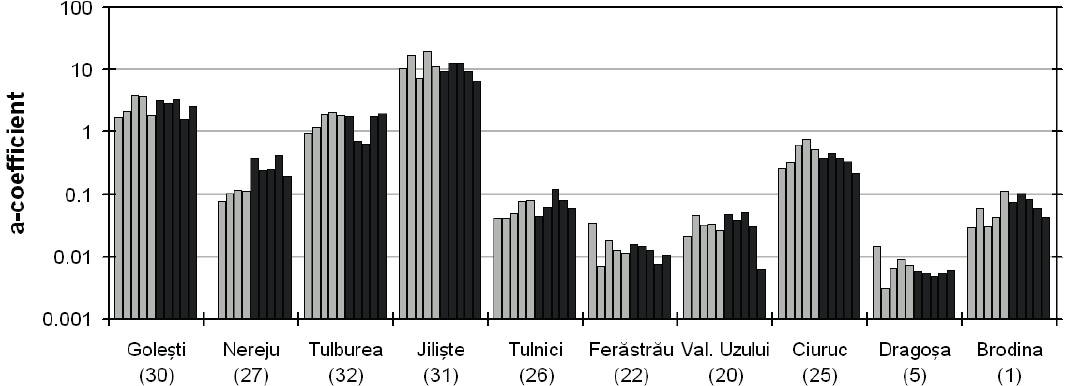
Fig. 3 a coefficients of the sediment rating curves (equation (1)) for the five consecutive hydrological years before (light grey) and after (dark grey) the M w 7.4 earthquake of 4 March 1977. The gauging stations are ordered according to their increasing distance from the epicentre (numbers correspond with those on Fig. 1). Note that only Nereju shows a consistent increase in a coefficient after the